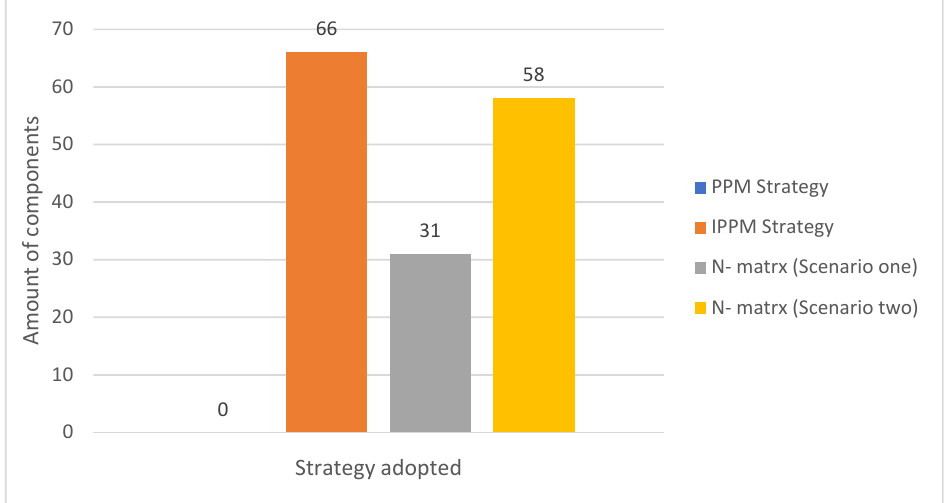
Figure 8. Comparison of the global number of components that require stock due to the maintenance strategy adopted.